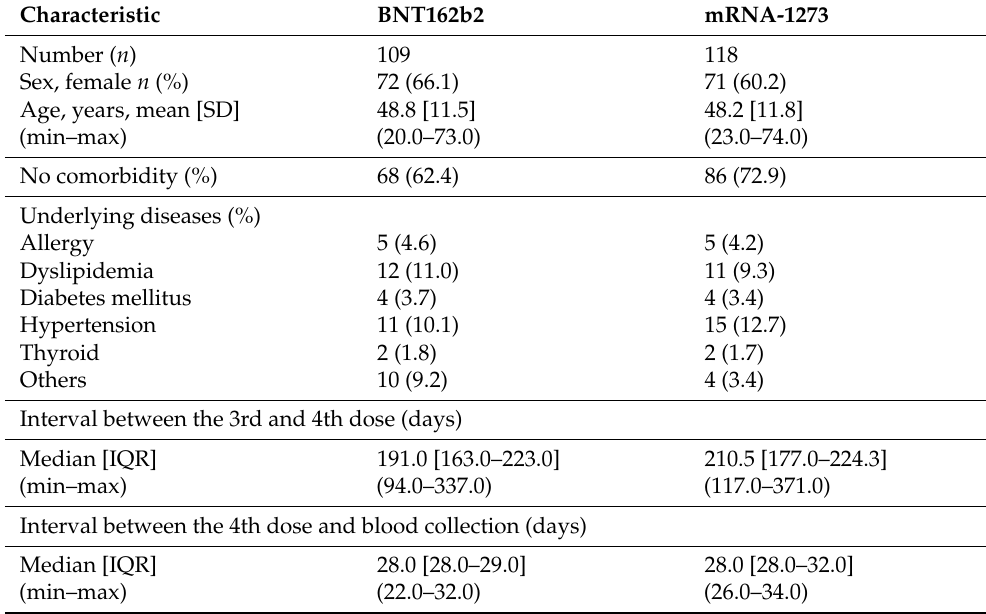
Table 1. Characteristics of the individuals who received a fourth booster COVID-19